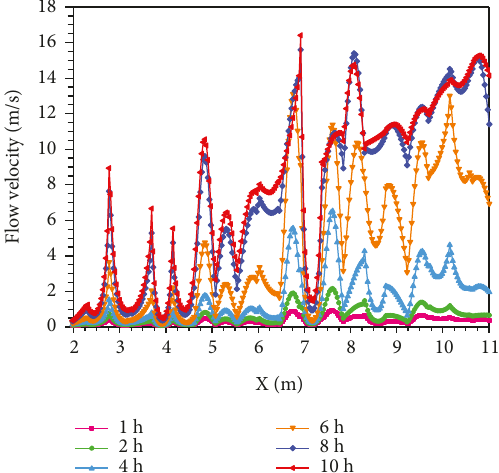
Figure 10: The fl ow velocity curves of the outlet boundary at di ff erent